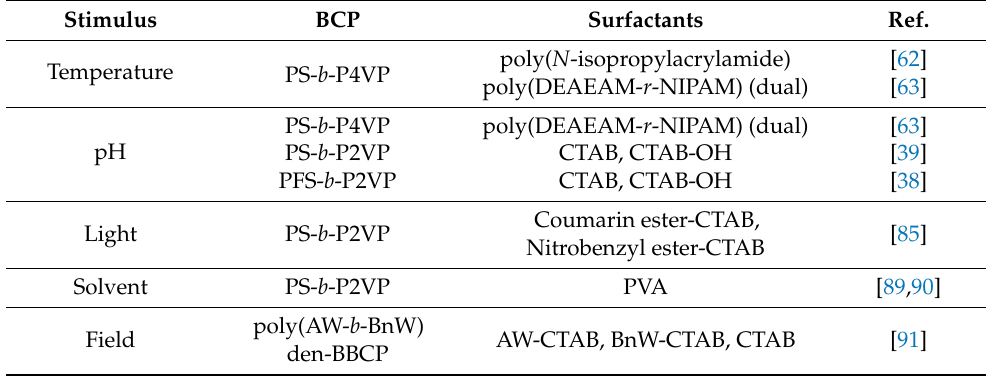
Table 1. Summary of responsive BCP